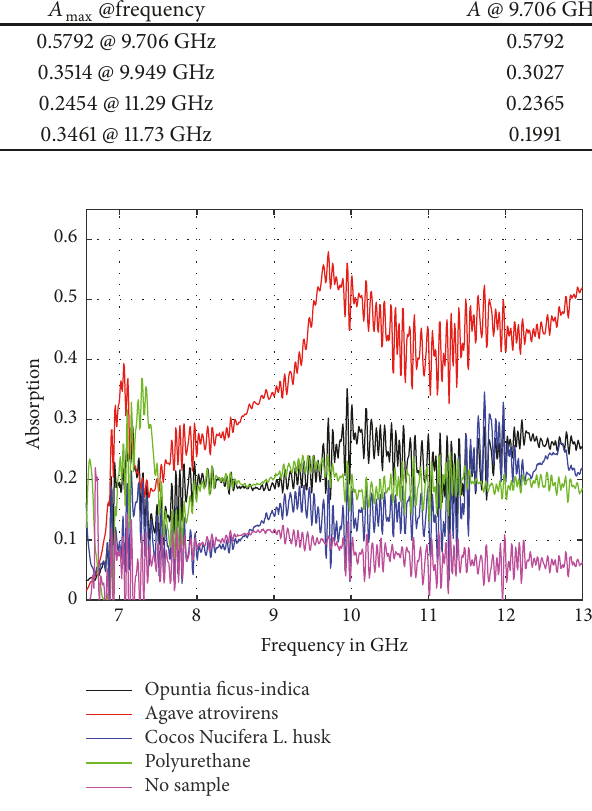
Figure 5: Absorption A for the waveguide considering samples of organic materials, polyurethane, and no